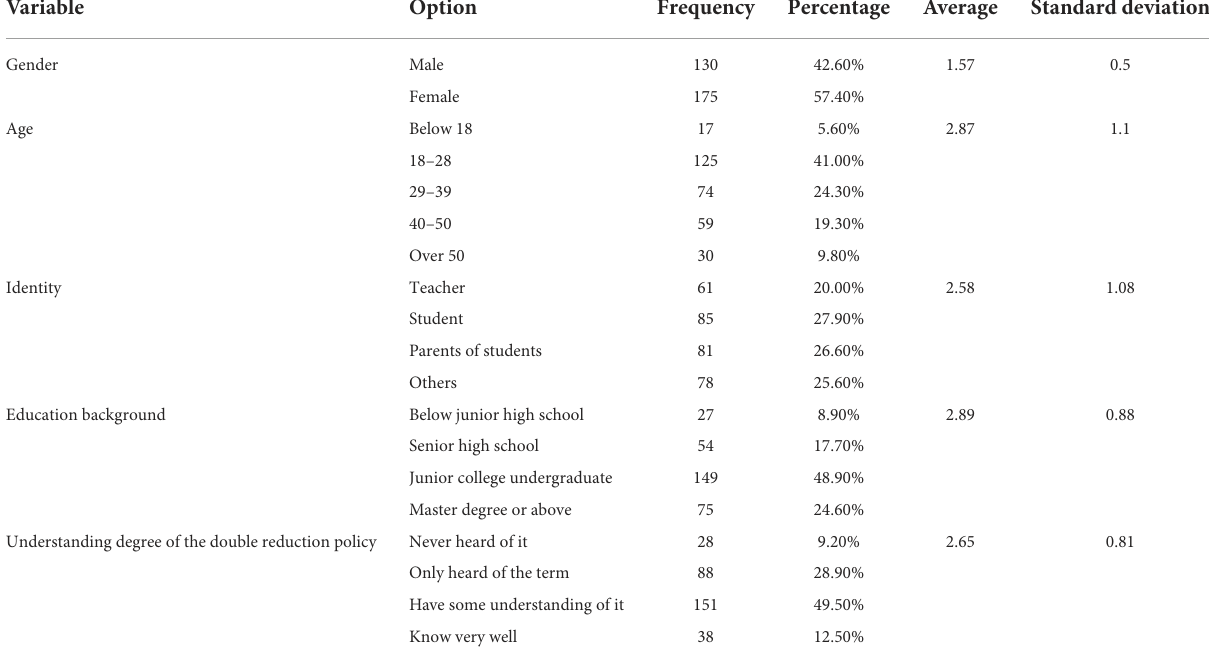
TABLE 1 Frequency analysis of demographic variables.